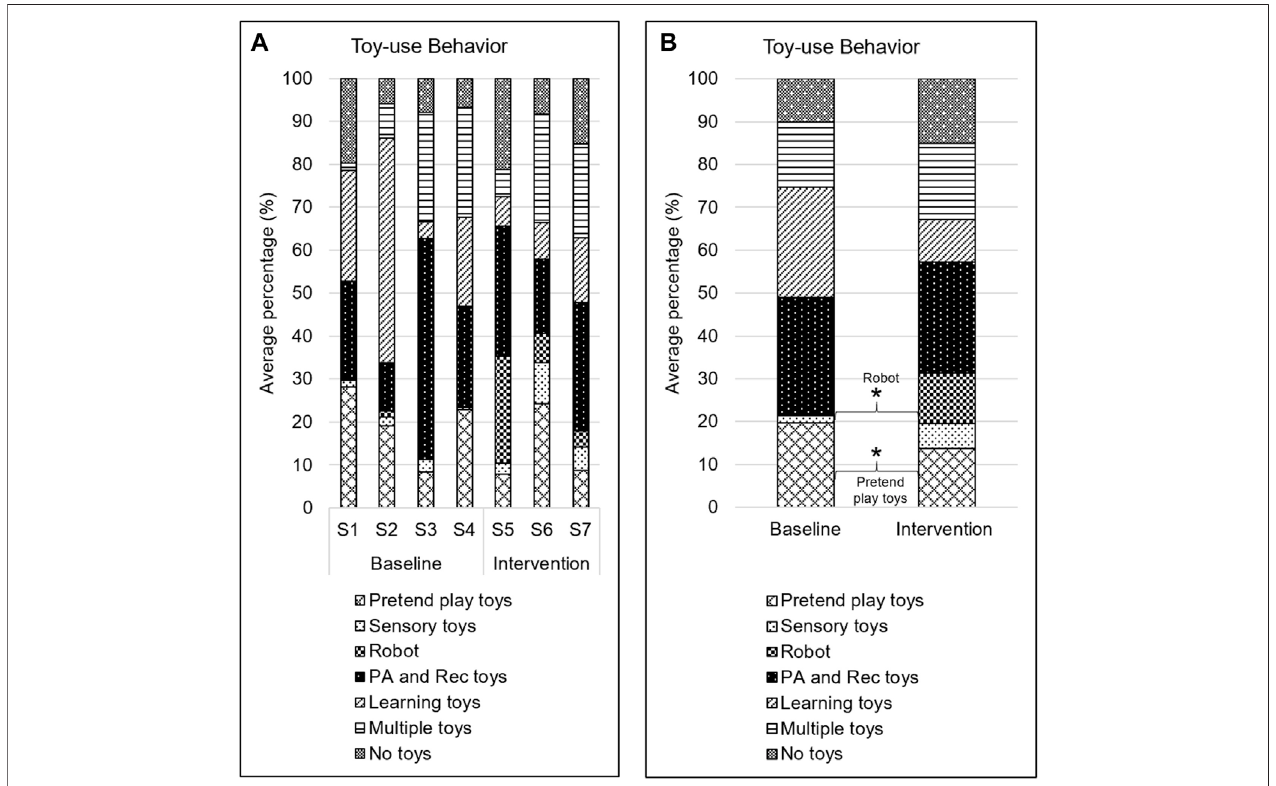
FIGURE 4 | Toy-use behavior. A . Average percentage of intervals spent interacting with each type of toys. S# on the x -axis represents the session number. B . Average percentage of intervals spent playing with each type of toy during baseline and intervention phases. * → p < 0.05.